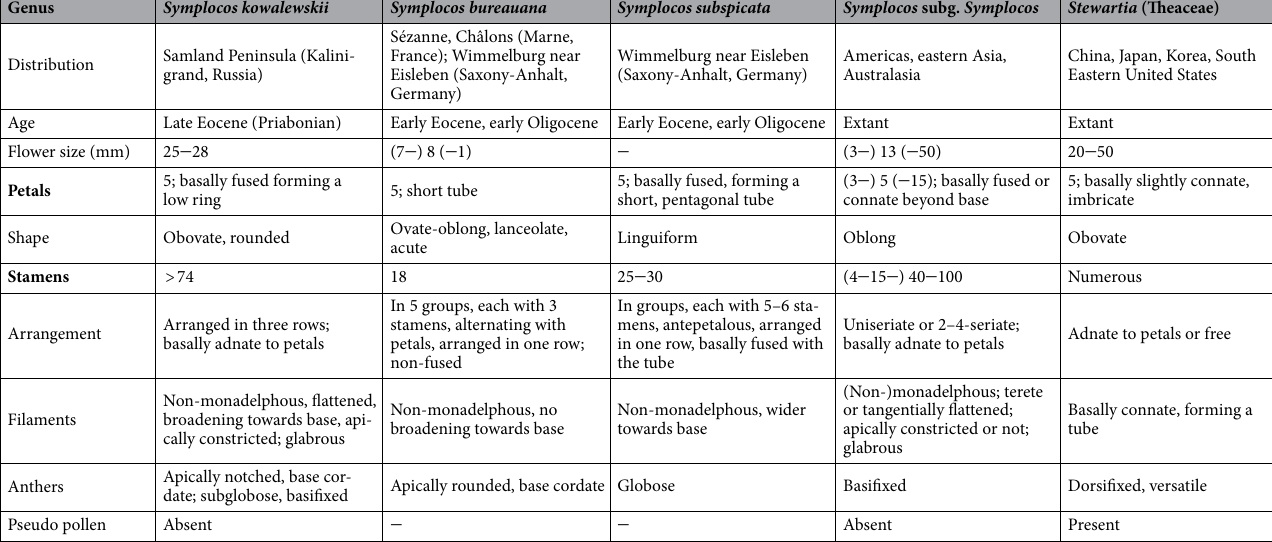
Table 1. Comparison of Symplocos kowalewskii comb. nov. et emend. from late Eocene Baltic amber to fossil and extant flowers of the Symplocaceae and Theaceae. Information that was not available is indicated with ‒ . Data from 29,32,33,35–38,40,55–57,74,76,96,97 . Flower diameter of S. bureauana measured from the holotype